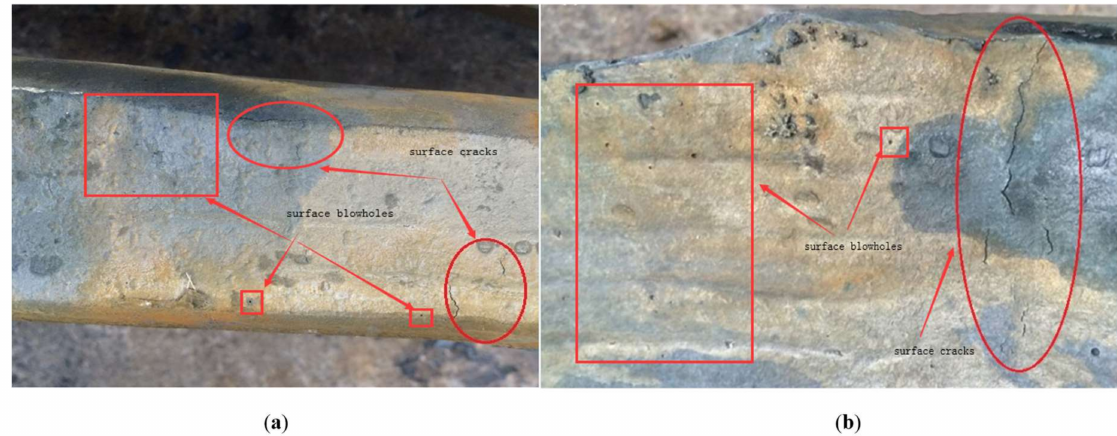
Figure 2. Surface cracks and blowholes on ( a ) web and ( b ) fillet of actual beam blank